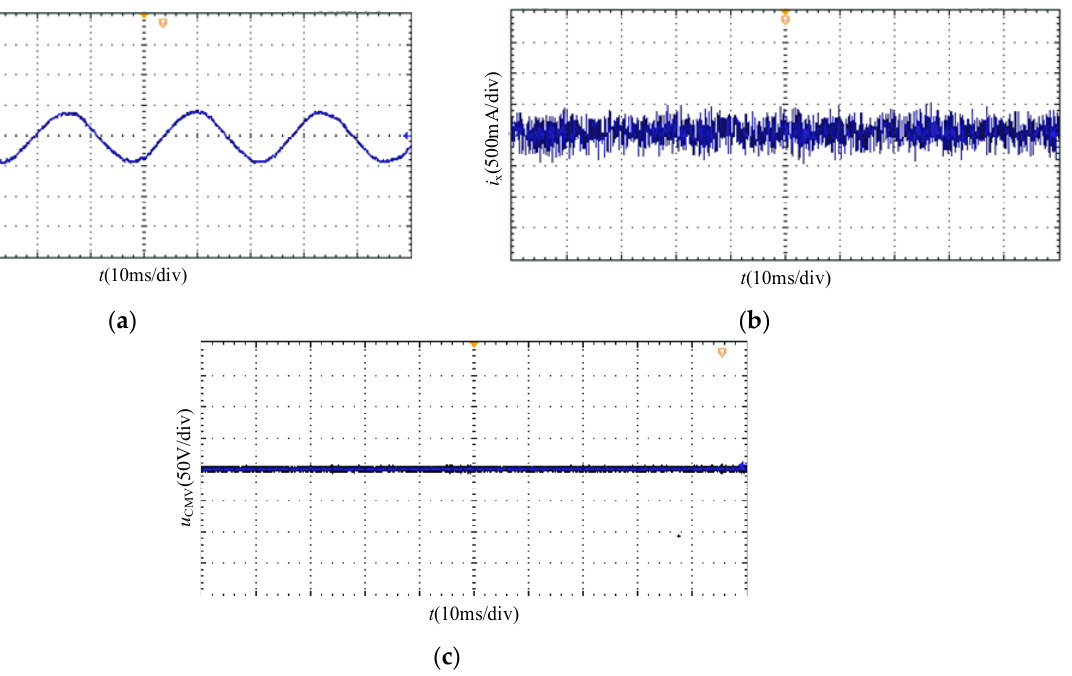
Figure 17. Steady experimental waveforms of MPTC2: ( a ) a-phase stator current; ( b ) harmonic current component i x ; ( c ) common-mode voltage.